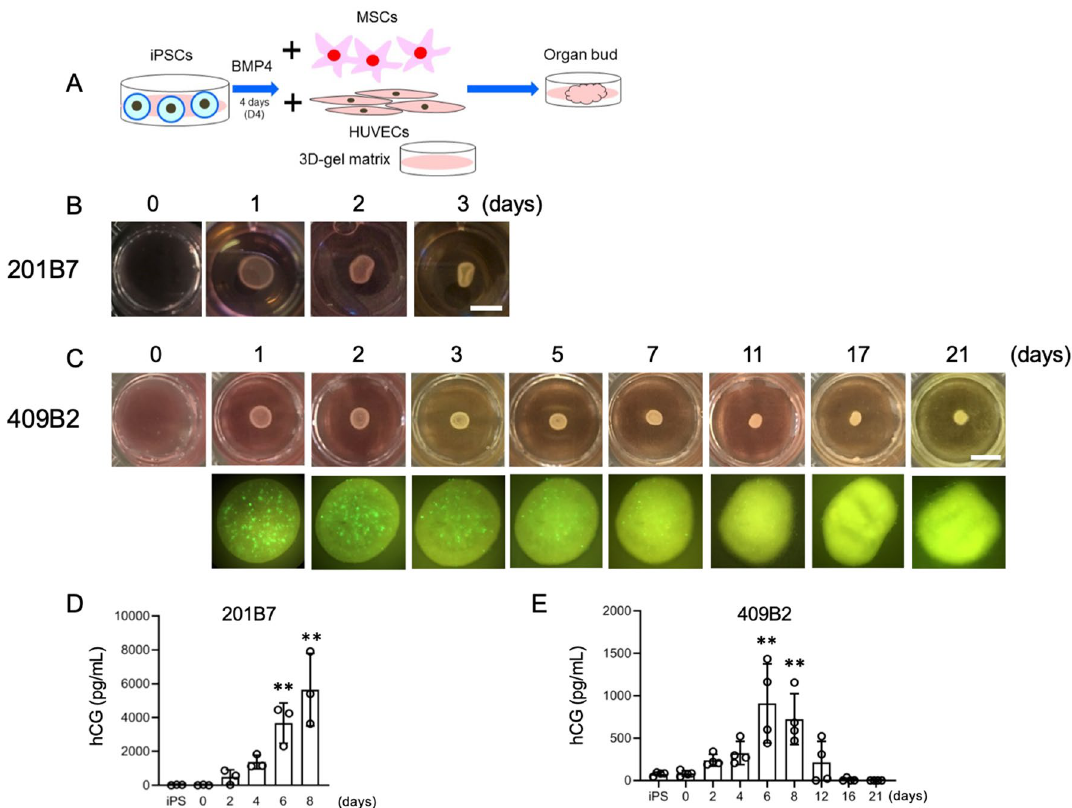
Figure 2. Placental organ buds synthesized from iPSCs. ( A ) Our scheme for synthesizing placental organ buds from iPSCs. ( B ) Representative images of three-dimensional placental buds after co-culture with HUVECs and MSCs for 0–3 days. 201B7 iPSCs treated with BMP4 for 4 days (D4) were utilized. Bars, 5 mm. ( C ) Representative images of placental buds after co-culture with HUVECs and MSCs for 0–21 days. 409B2 iPSCs treated with BMP4 for 4 days (D4) were utilized. Macroscopic views (upper panels) and the views under fluorescence microscope (lower panels). Note that 409B2 iPSCs contain GFP, so the iPSCs were identified by green fluorescence. Bars, 5 mm. ( D ) hCG levels in the medium of placental organ buds from 0 to 8 days. 201B7 iPSCs treated with BMP4 for 4 days (D4) were utilized. iPS represents the cells before BMP4 treatment. hCG levels were statistically analyzed by ANOVA, and the hCG level on each day was compared to that of iPSCs in post-hoc test. n = 3 in each group. ( E ) hCG levels in the medium of placental organ buds from 0 to 21 days. 409B2 iPSCs treated with BMP4 for 4 days (D4) were utilized. iPS represents the cells before BMP4 treatment. hCG levels were statistically analyzed by ANOVA, and the hCG level on each day was compared to that of iPSCs in post-hoc test. n = 3 in each group. **, P <